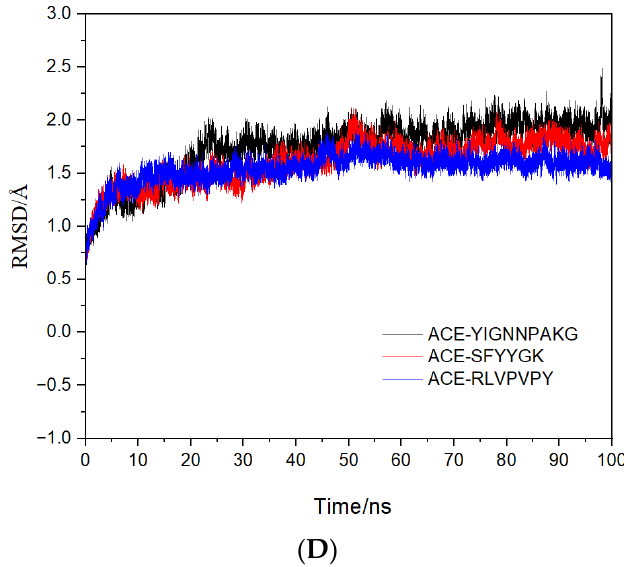
Figure 5. Molecular simulation of the interactions between peptides and ACE: Molecular docking of ( A ) SFYYGK, ( B ) RLVPVPY and ( C ) YIGNNPAKG; ( D ) the changes in RMSD between ACE − peptide complexes.